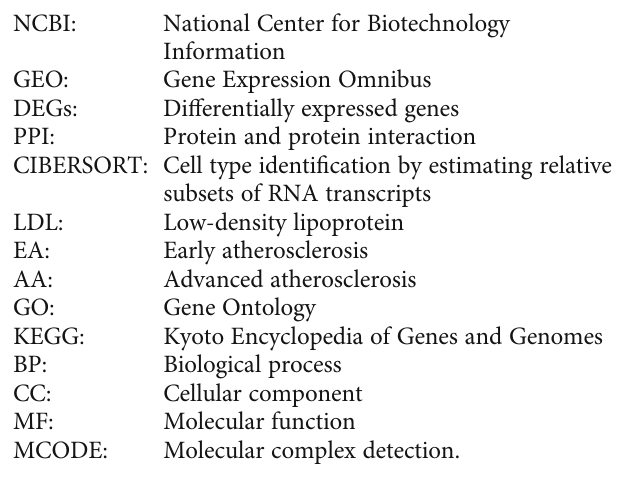
Figure S1: the chord plot for functional enrichments of mod- ule 1 genes. Figure S2: the scatterplot of correlation between CTSS expression and the relative proportion of T cell gamma delta. Gray-shaded areas in scatterplots represent the stan- dard errors of the blue regression lines. R : correlation coe ffi - cient. Figure S3: the scatterplot of correlation between 17 gene expressions and the proportion of dendritic cells activated. Gray-shaded areas in scatterplots represent the standard errors of the blue regression lines. R :